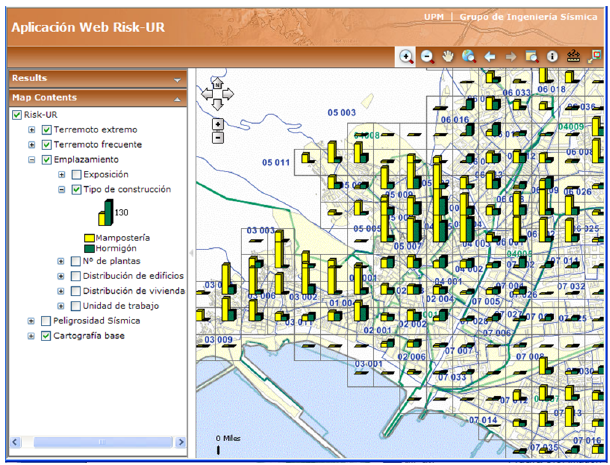
Fig. 6. Web visualiser image showing the distribution of masonry (yellow) and reinforced concrete (green) in every working unit.